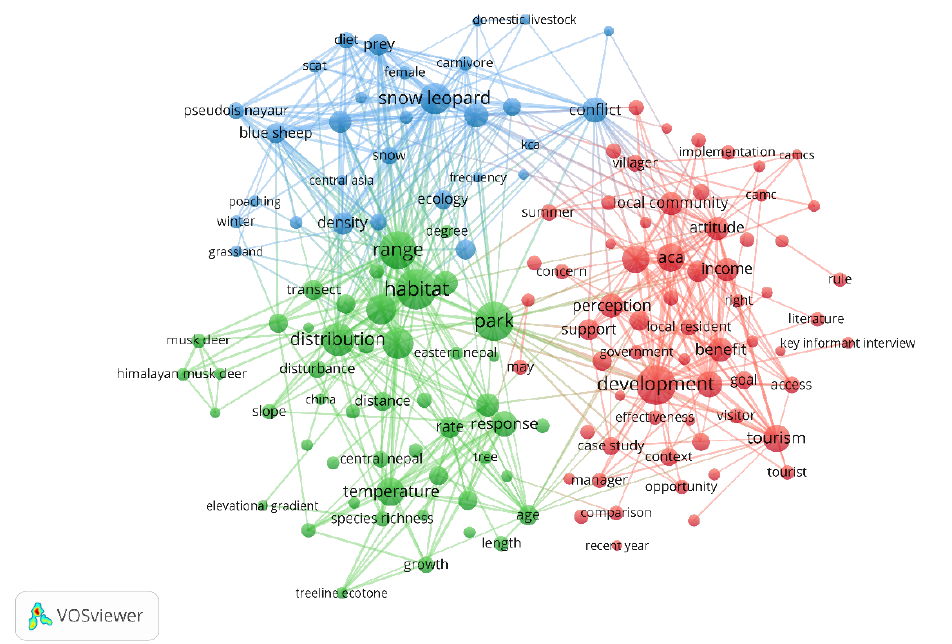
Figure 12. Mapping of “Conservation Areas”.